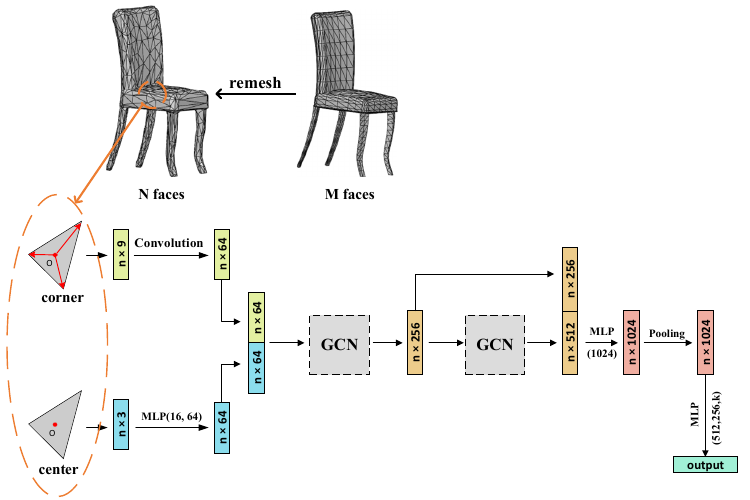
Figure 2. Algorithm flow chart. (After feature extraction of the faces, they are input to the classification network for aggregated vertex information and then pooled to obtain global features. Finally, the classification results are